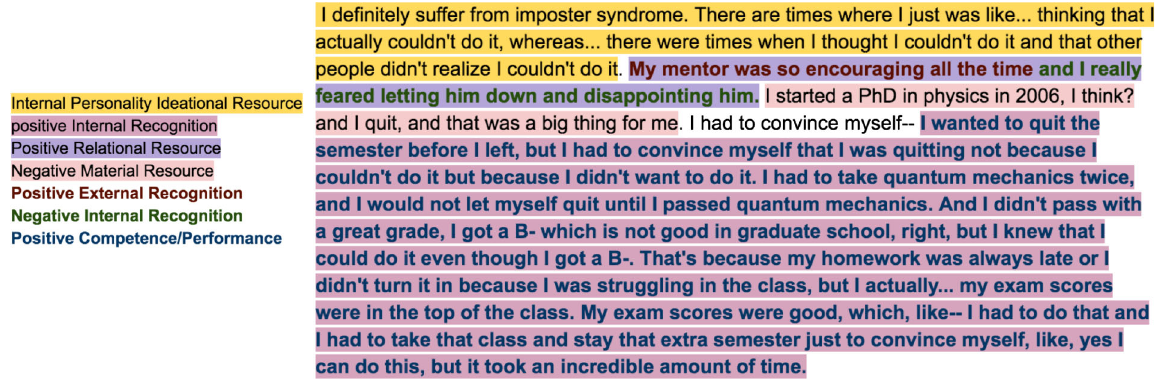
FIG. 2. An excerpt from Cara ’ s coded interview using the Critical Physics Identity